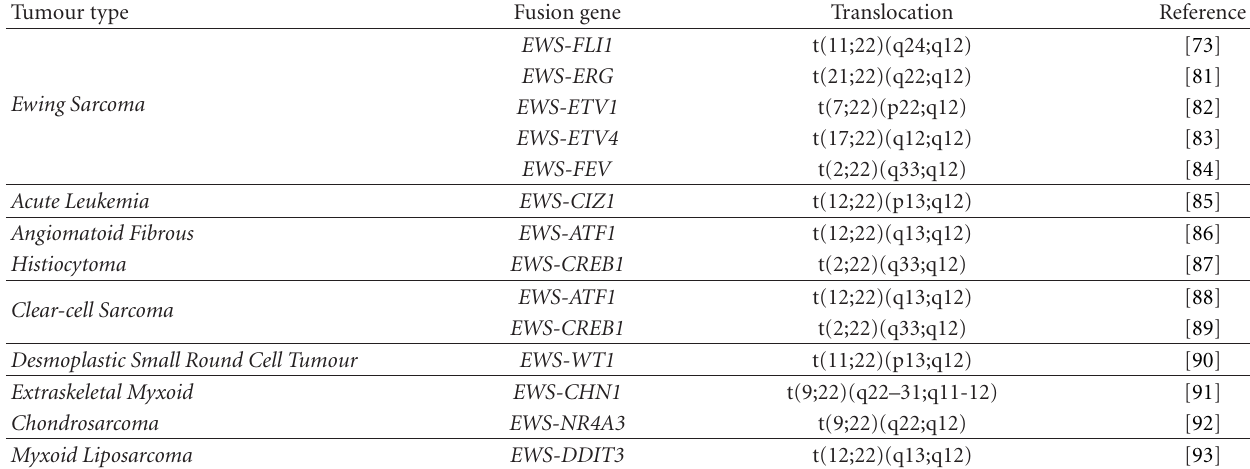
Table 4: Involvement of the EWS gene in translocation-based